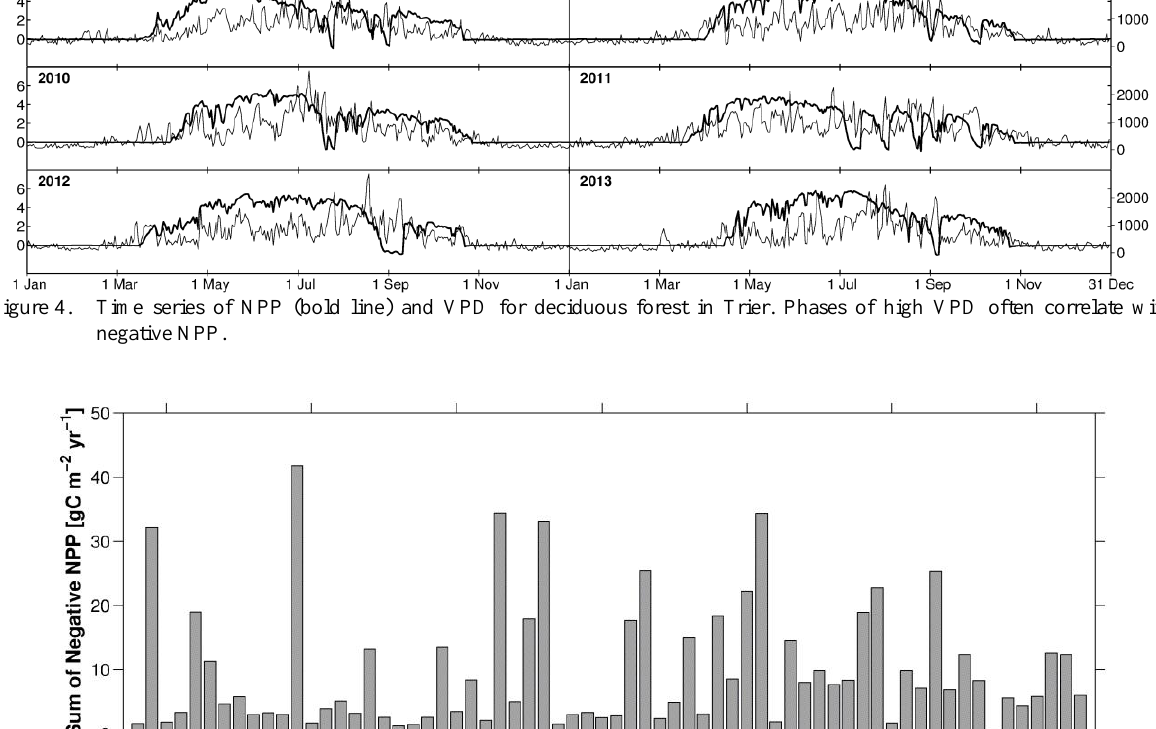
Figure 5. Sums of negative NPP for the years 1948 to 2013 for DBF in